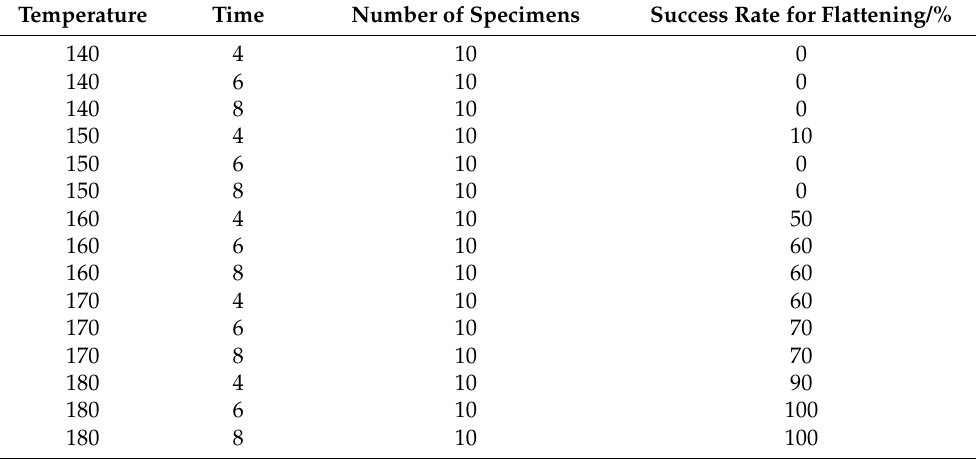
Table 1. The success rate of flattened bamboo board at different temperatures and times. Temperature Time Number of Specimens Success Rate for Flattening/% 140 4 10 0 140 6 10 0 140 8 10 0 150 4 10 10 150 6 10 0 150 8 10 0 160 4 10 50 160 6 10 60 160 8 10 60 170 4 10 60 170 6 10 70 170 8 10 70 4 10 90 10